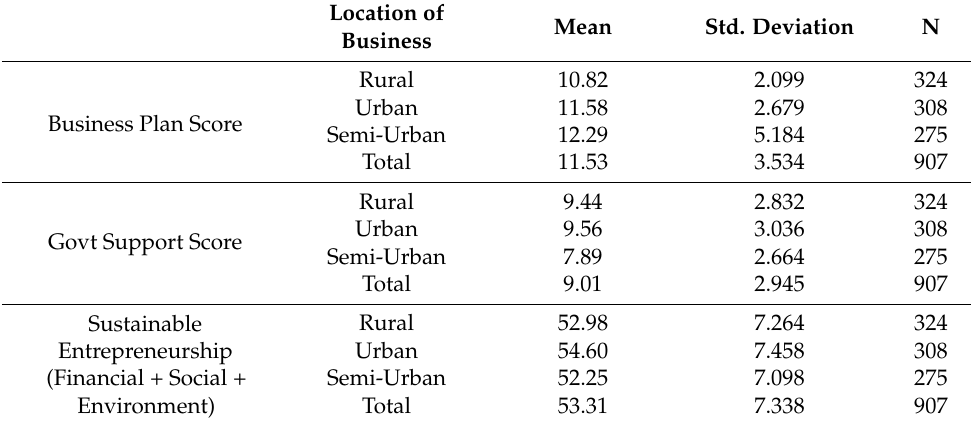
Table 7. Descriptive